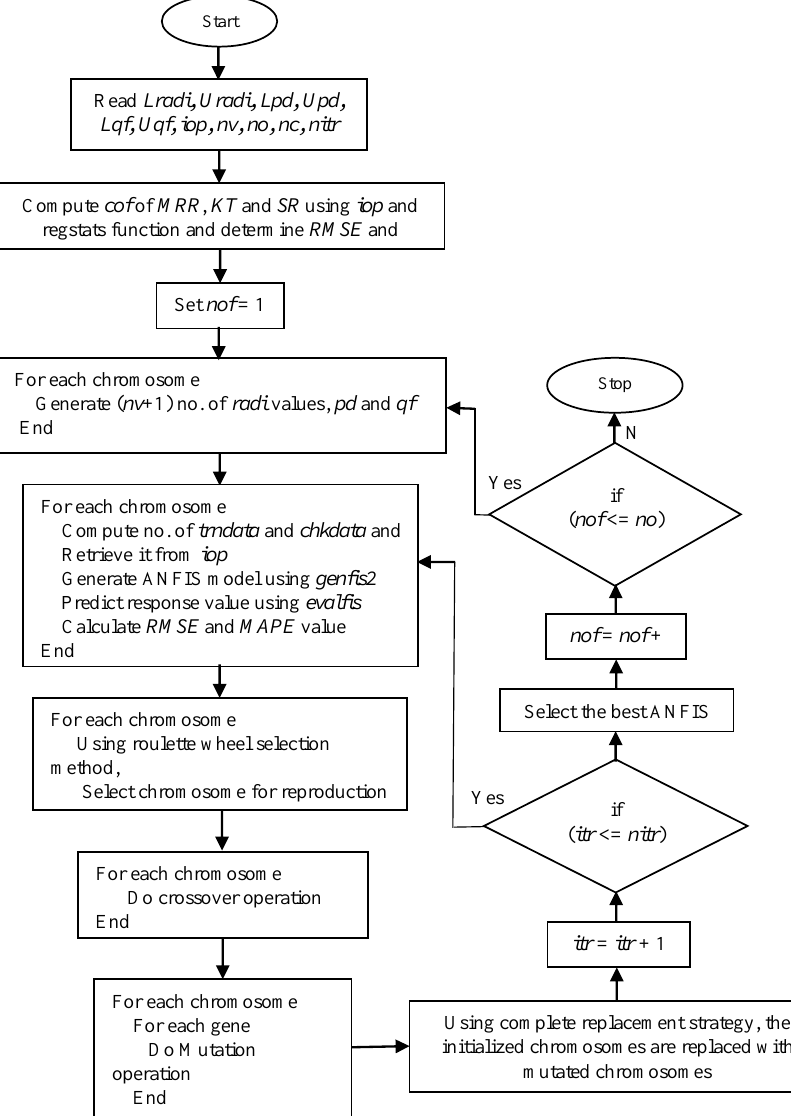
Figure 3. Implementation of GA for the development of ANFIS model.